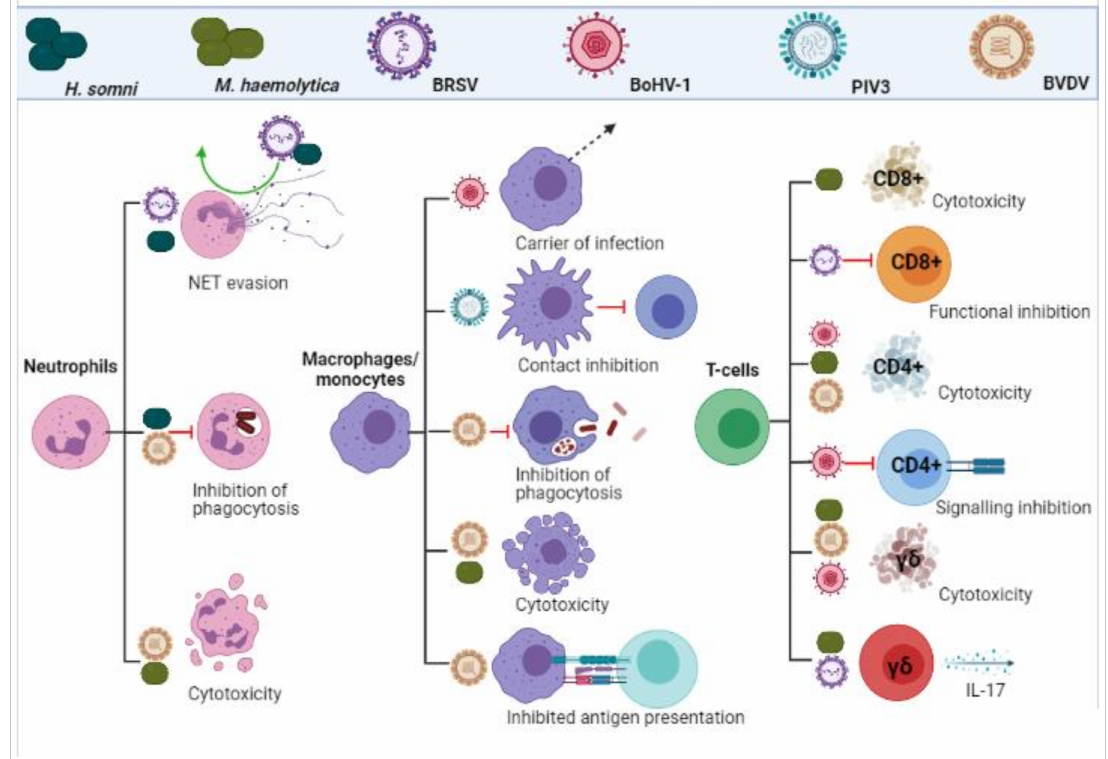
Figure 2. Leukocyte evasion and inhibition by BRDC pathogens. Viral and bacterial infections inhibit functionality, impact signalling and induce cytotoxicity in cells of the adaptive and innate immune response. (Created in BioRender.com, accessed on 24 March